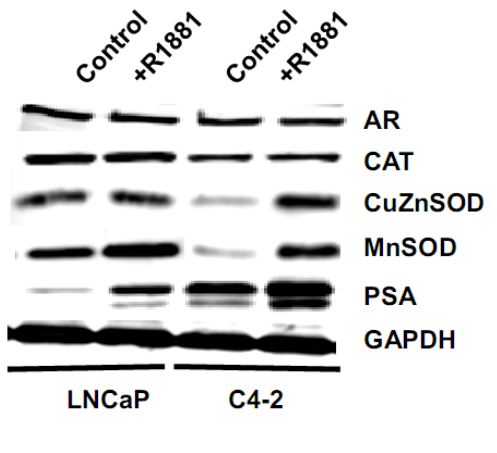
Figure 11. Effect of androgen on levels of redox-related protein expression in LNCaP and LNCaP-C4-2 cells. Cells were treated with 1 nM R1881 for 48 h. Cells were collected and lysates were used for western blot analysis. AR, CAT, CuZnSOD, MnSOD, and PSA immunoreactive protein levels were analyzed. C4-2 = LNCaP-C4-2